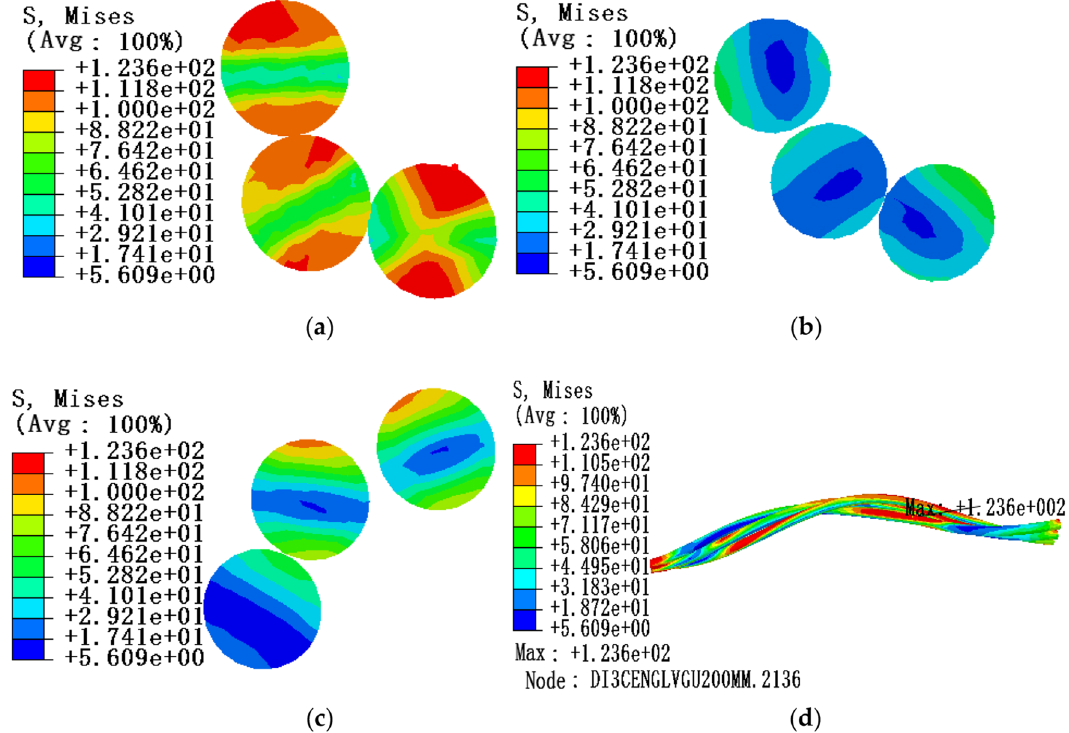
Figure 9. Equivalent stress cloud diagram of aluminum strand at 10% RTS ( a) Equivalent stress cloud diagram at maximum stress; ( b ) Equivalent stress cloud diagram at 1 times the pitch diameter; ( c ) Equivalent stress cloud diagram at 0.5 times the pitch diameter; ( d ) Overall equivalent stress cloud diagram of aluminum strand.